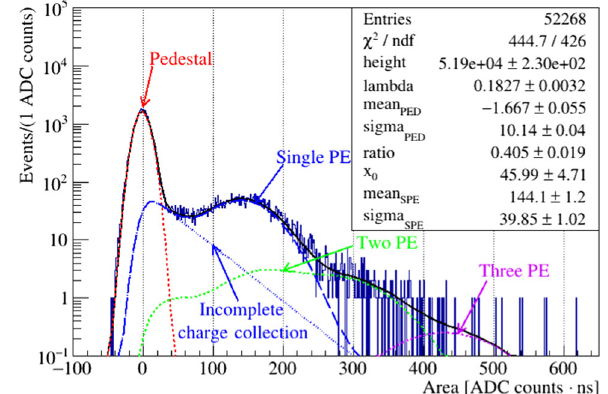
Fig. 4 TwohundredconsecutivewaveformsfromthePMToverlapped Fig. 5 Single PE response of the PMT in logarithm scale